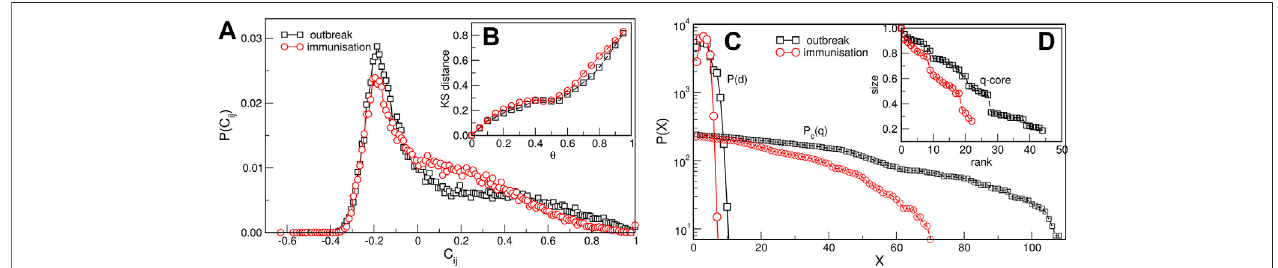
FIGURE2| Networkmeasures. (A) Thenormalisedprobabilitydensityfunctionofthe fi lteredcorrelationcoef fi cientsfortheoutbreakandimmunisationperiods. (B) The Kolmogorov-Smirnov distance between the eigenvalue spectrums of networks obtained for θ = 0 and different values of θ > 0, plotted against θ > 0. (C) The distribution of the shortest-path distances P ( d ) vs . the distance d and the cumulative distribution P c ( q ) of the node ’ s degree q for the outbreak and immunisation networks with the threshold θ = 0.5. (D) The size of the q-core of these networks plotted against the